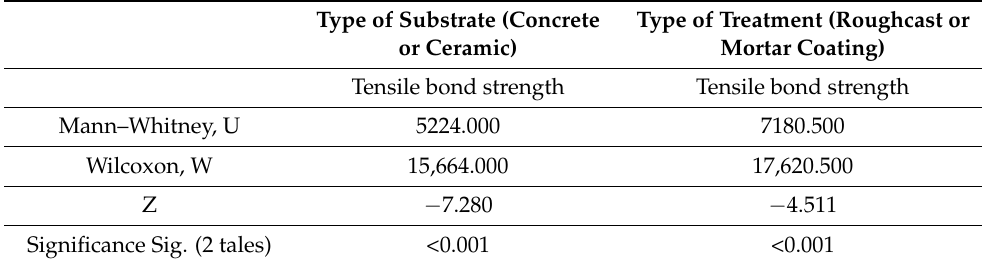
Table 8. Mann–Whitney test statistic result for the influence of the type of substrate and type of treatment on the tensile bond strength.